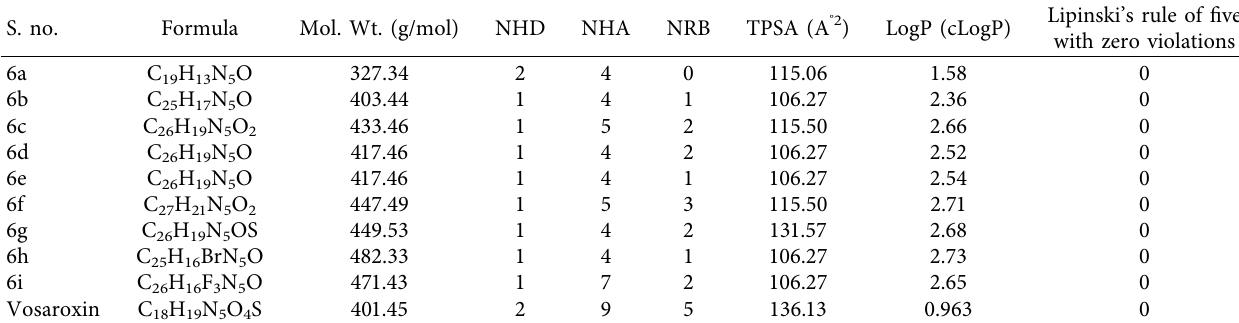
Table 6: Drug-likeness predictions of compounds 6a-i, computed by SwissADME.